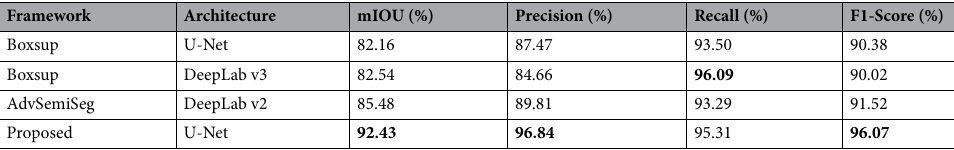
Table 3. Comparison with state-of-the-art semi-supervised segmentation algorithms. The learning strategy and verification of all results were carried out in the same way as in Fig. 7. Best results are shown in [bold].